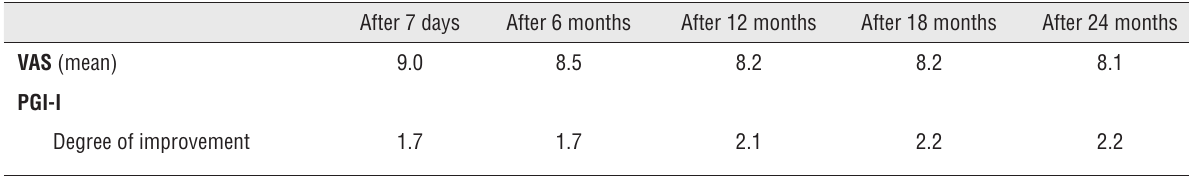
Table 6 - Patients’ satisfaction after treatment with Bulkamid®, assessed by Visual Analogue Scale (VAS) and Patient Global Impression of Improvement questionnaire